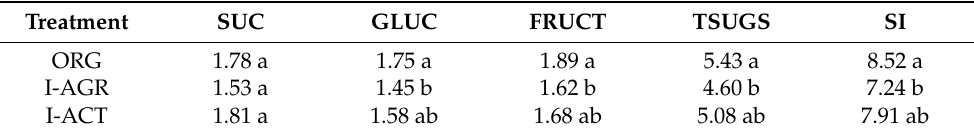
Table 6. Effects of cultivation management on fruit carbohydrate concentration (% F.W.) and sweet- ness index of the fruit.